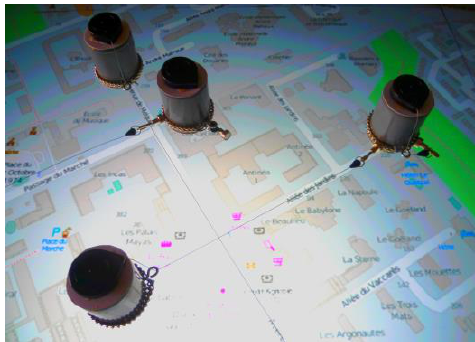
Figure 4. Tangible objects on the collaborative table. Here the objects represent either buildings or crossings. Their position and identity are monitored by the system. Streets are “materialized” using badge reels’ strings. The objects are filled with lead to prevent the users from knocking them down when exploring the